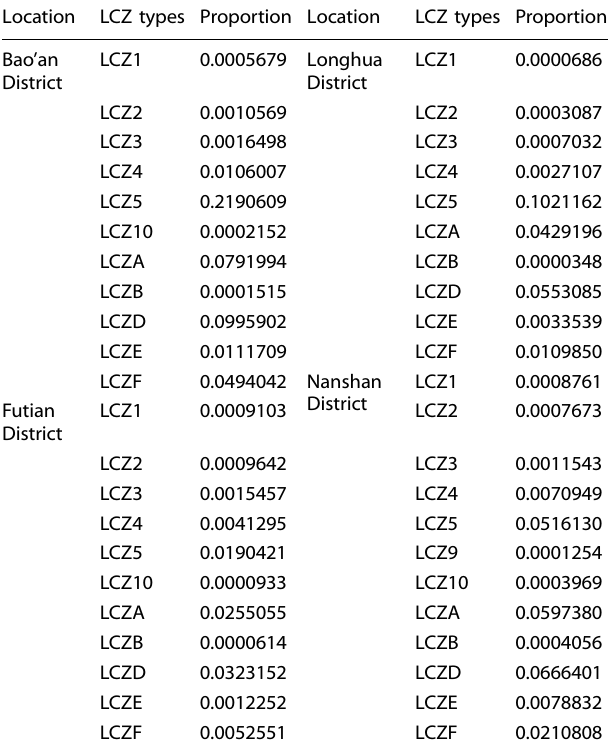
Table 1. The statistical results of different LCZs in different regions.